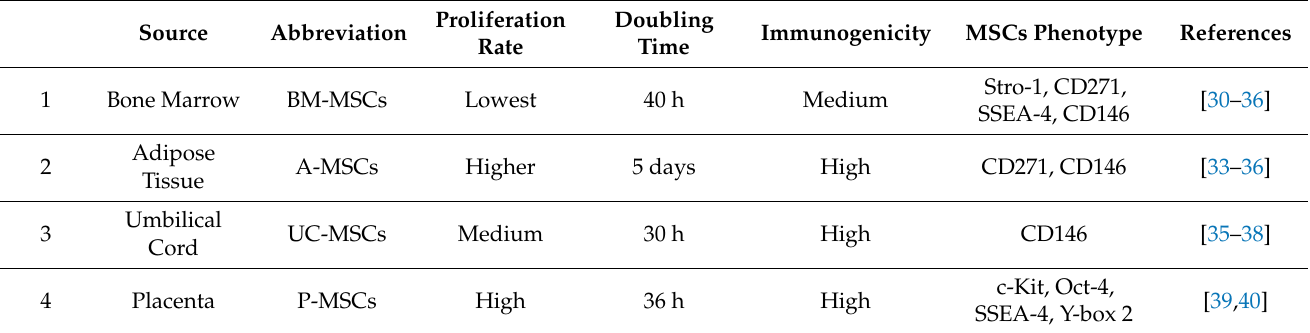
Table 1. Commonly used sources of